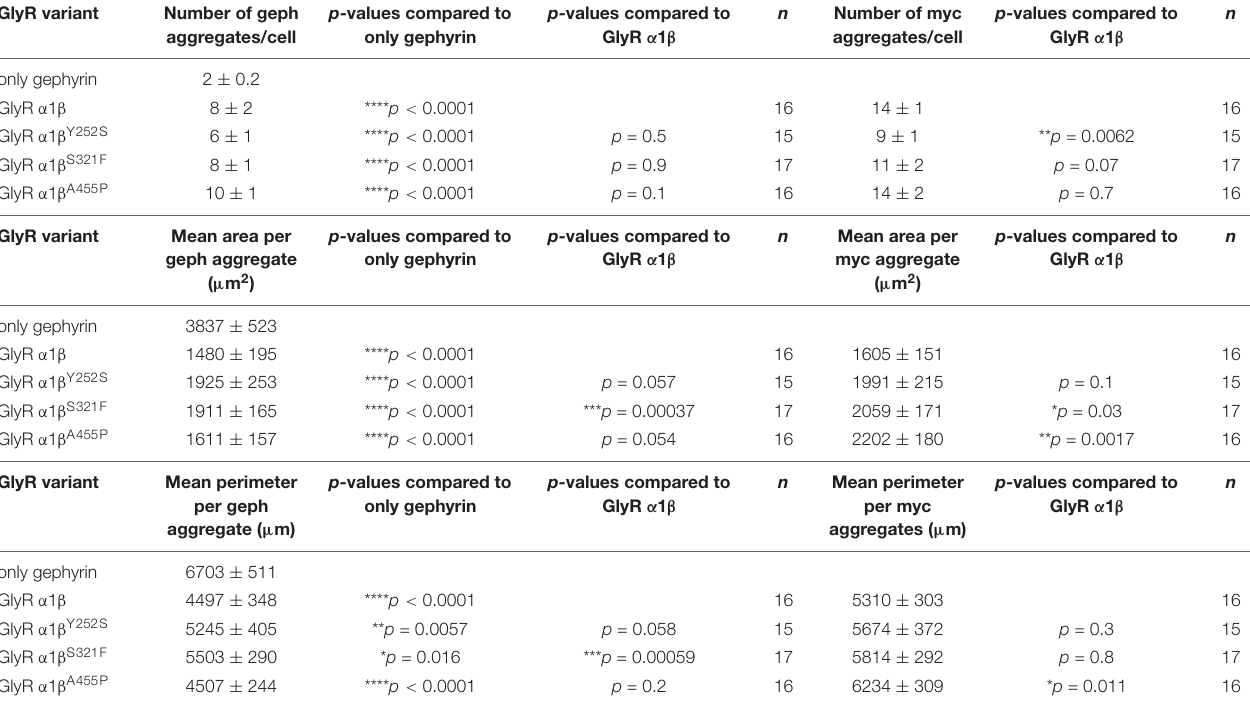
TABLE 3 | Quantification of GlyR β and gephyrin accumulations in transfected cells. GlyR variant Number of geph p -values compared to p- values compared to aggregates/cell only gephyrin GlyR α 1